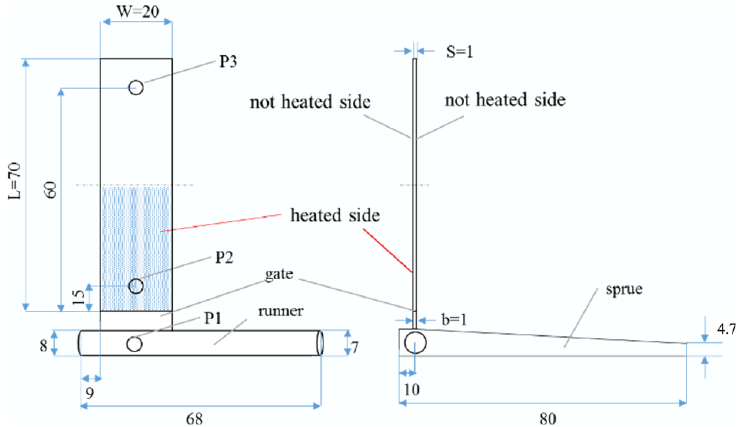
Figure 1. Cavity sketch and dimensions.